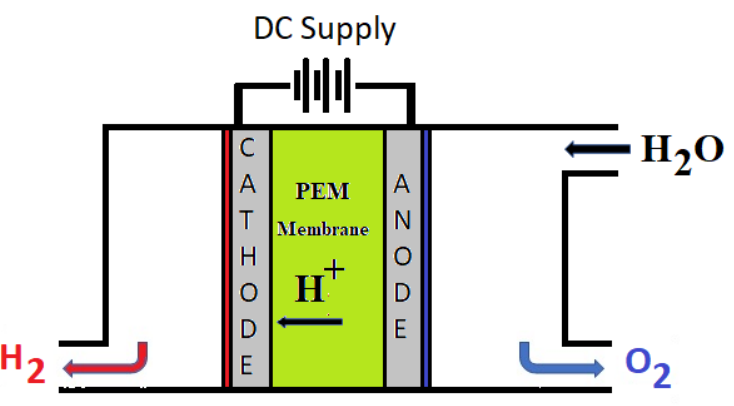
Figure 2. PEM electrolyzer.